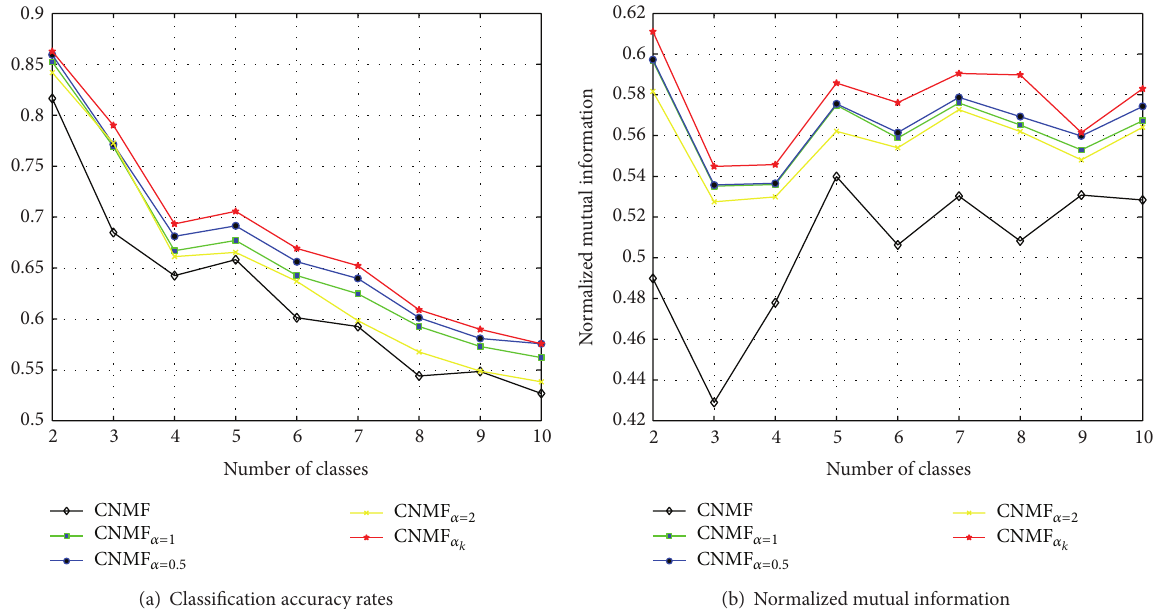
Figure 2: Classification performance on the Yale Database.